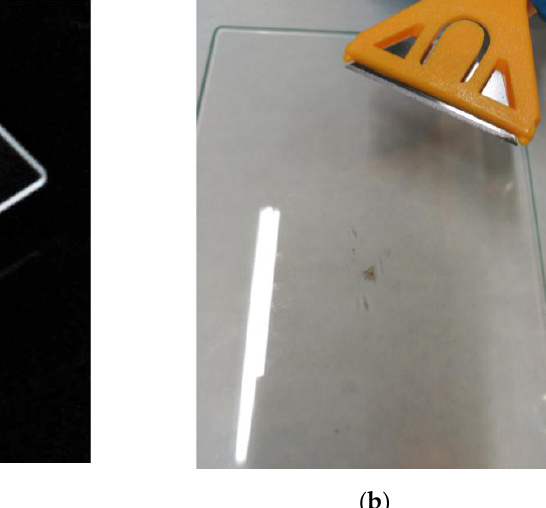
Figure 3. A female Vespa velutina specimen in the milking grid: ( a ) Resting, venom collection device off; ( b ) Bending the tip of their abdomen downward and stinging after receiving an electrical shock, venom collection device on; ( c ) Deposited liquid globules of venom over the glass plate (red arrows).